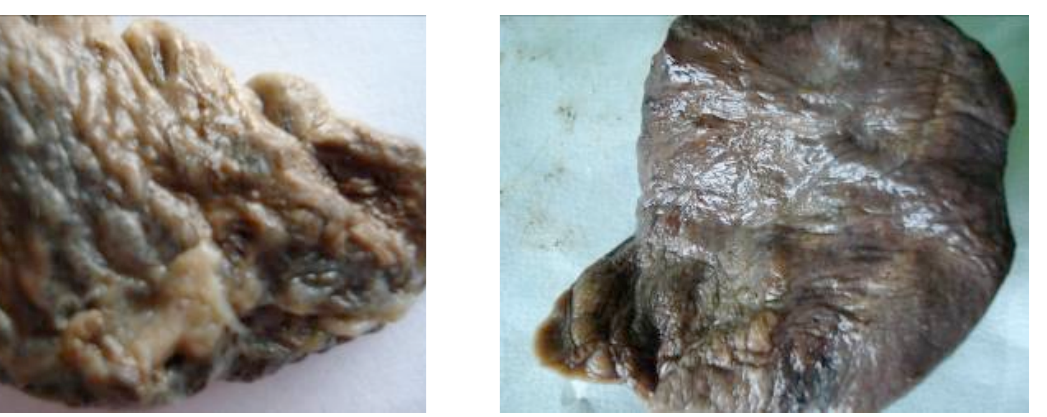
Image 9. Lung of Golden Pheasant showing caseous nodules and black-brown with greenish-black coloration all over